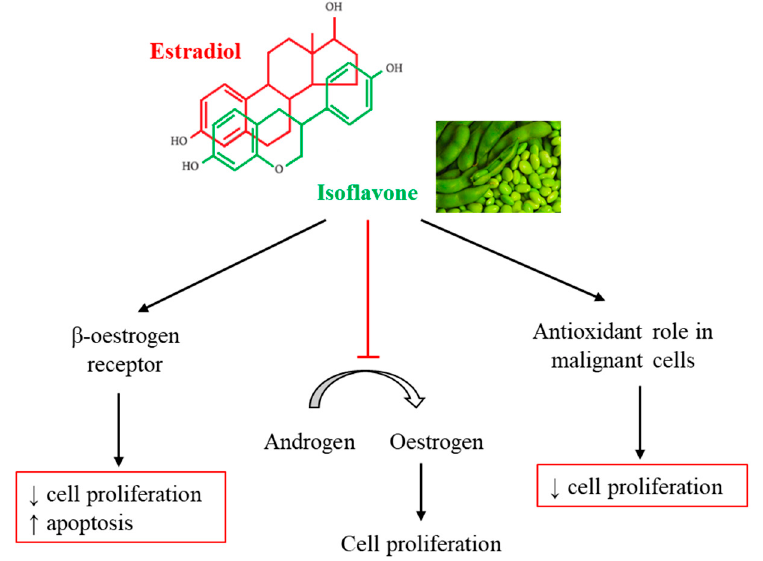
Figure 5. Possible mechanism of action of isoflavones for cancer prevention.